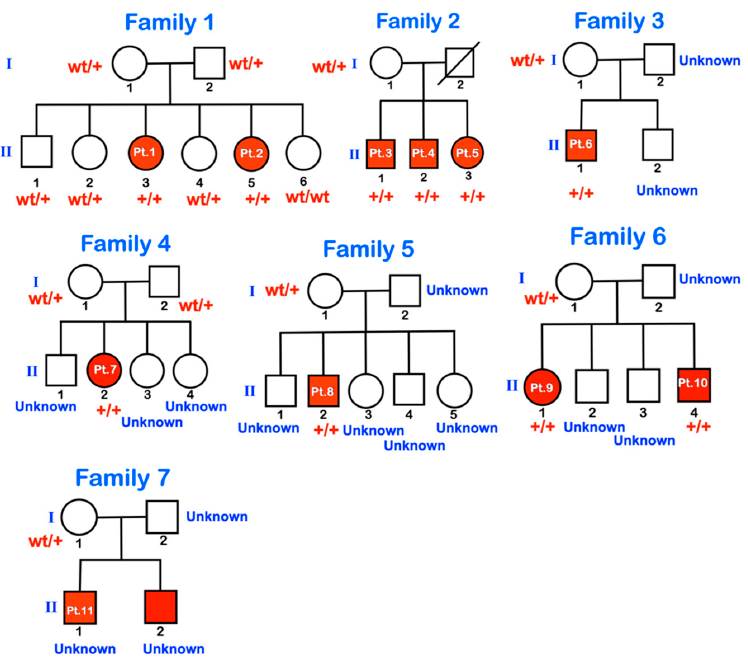
Figure 1. Pedigrees of families 1–7. wt = wild type; +/+ = homozygous for the variant; wt/+ = heterozygous for the variant. Unknown means genetic testing was not performed. All patients were delivered by midwives at term. Parents reported no history of teratogenic exposure or drug ingestion during pregnancy. The information regarding the pregnancy was minimal. The families were poor and not well educated. Parents were unable to provide information on the medical histories of their children. All affected patients had white sclerae and a short barrel-shaped chest. Ten patients (patients 1–9 and 11) were available for clinical and radiographic examinations. Patient 10 had a clinical examination and molecular testing but not a radiographic examination. All patients were short and were not able to stand or walk. To get around, they slid on their trunk and pelvis by push- ing their hands against the ground. Sometimes, they use wheelchairs when available. Be- sides brittle bones, their general health was unremarkable, except for patient 3, who, ac- cording to his parents’ verbal report, defecated once every three months. All patients were cheerful with normal intelligence. The health of all parents was unremarkable.